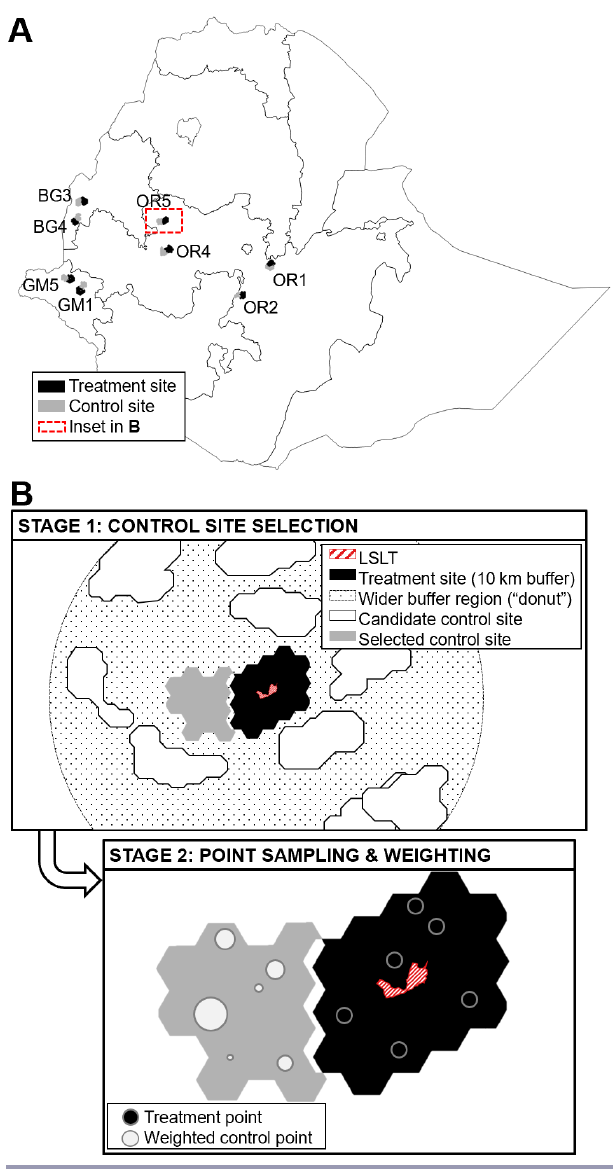
Fig. 1 . (A) Site locations within Ethiopia and (B) schematic illustration of the two-stage treatment-control